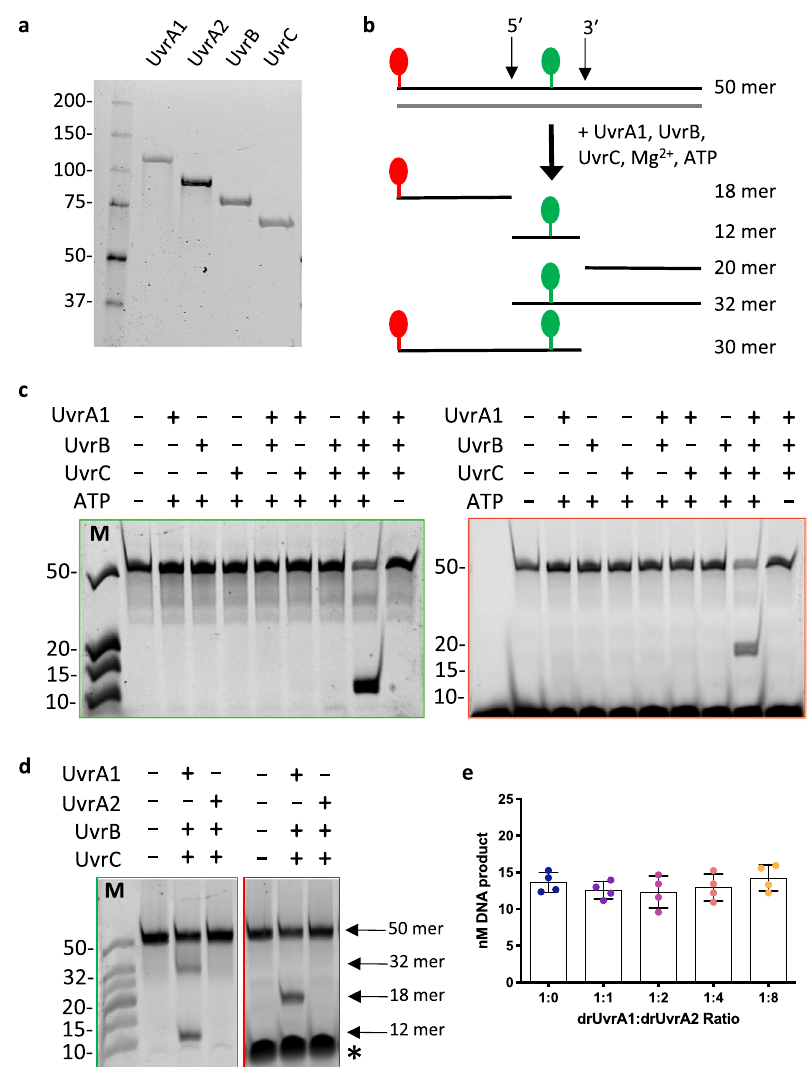
Fig. 1 Deinococcus radiodurans UvrABC system. a SDS-PAGE analysis of the puri fi ed drUvrA1, drUvrA2, drUvrB, and drUvrC proteins from D. radiodurans . The fi rst lane corresponds to molecular weight markers in kDa. b Schematic diagram illustrating the design of the dsDNA substrates used in this study and the sites of incision by drUvrABC on the 5 ′ and 3 ′ sides of the lesion, corresponding to a fl uorescein-conjugated thymine (green). An additional red fl uorophore was added to the 5 ′ end of the substrates to allow to differentiate the DNA fragments released on the 5 ′ and 3 ′ sides of the lesion. c TBE- polyacrylamide urea-gel analysis of the drUvrABC incision activity in the presence or absence of each of the three Uvr proteins or ATP. Reactions were performed for 1 hour at 37 °C using 25 nM F26-seq1 substrate and different combinations of drUvrA1 (1 µ M), drUvrB (0.5 µ M), and drUvrC (2 µ M) in the presence of 2.5 mM Mg 2 + and 2.5 mM ATP. d TBE-polyacrylamide urea-gel analysis of the drUvrABC incision activity in reactions containing either 1 µ M drUvrA1 or 1 µ M drUvrA2. Reaction conditions were the same as in ( c ). The major bands observed by electrophoresis using either the green- or red fi lter are indicated with arrows. The large band indicated with a * in the red channel corresponds to the sample-loading dye that produces a strong fl uorescence in the red fi lter. c – d Green-boxed gels were visualized with the green fi lter to detect fl uorescein-labeled bands, whereas red-boxed gels were visualized with the red fi lter to detect ATTO633-labeled bands. Left lane: molecular weight marker composed of fl uorescein-labeled oligonucleotides ranging from 10 to 50 bp. e Effect of drUvrA2 on the incision reaction performed by drUvrABC. Reactions were performed at 37 °C for 45 min using 25 nM F26-seq1 substrate, 0.25 µ M drUvrA1, 0.5 µ M drUvrB and 2 µ M drUvrC (blue), supplemented with 0 (ratio 1:0), 0.25 (ratio 1:1), 0.5 (ratio 1:2), 1 (ratio 1:4), or 2 µ M (ratio 1:8) drUvrA2. All reactions contained 2.5 mM MgCl 2 and were started by addition of 2.5 mM ATP. Dot-plots present the mean amount of 12 mer product (nM) released and standard deviation of four individual replicates illustrated as individual